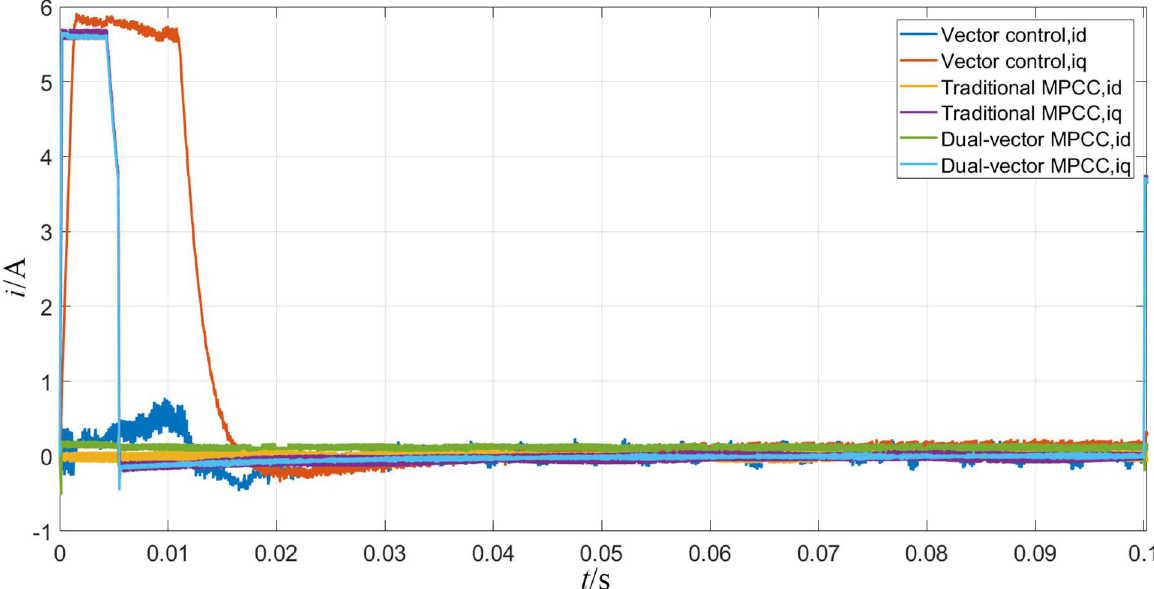
Fig 9. d-q axis current waveform when the motor starts.